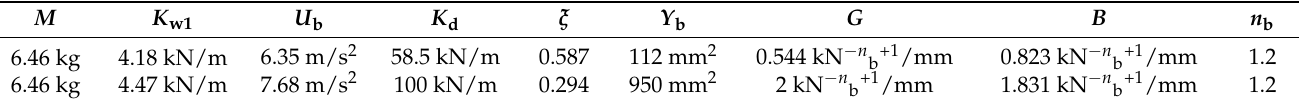
Table 6. The identified parameters of the damper experiments [35].